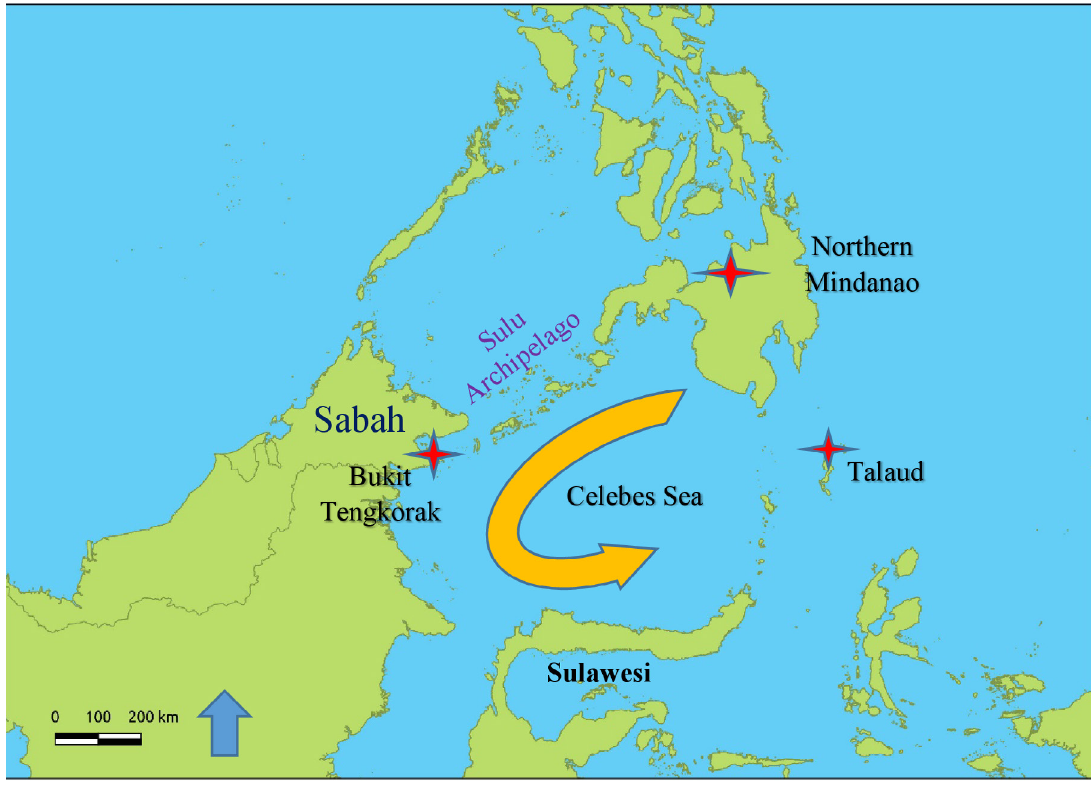
Figure 4. Possible movement of prehistoric seafarers along Celebes Sea during the Neolithic